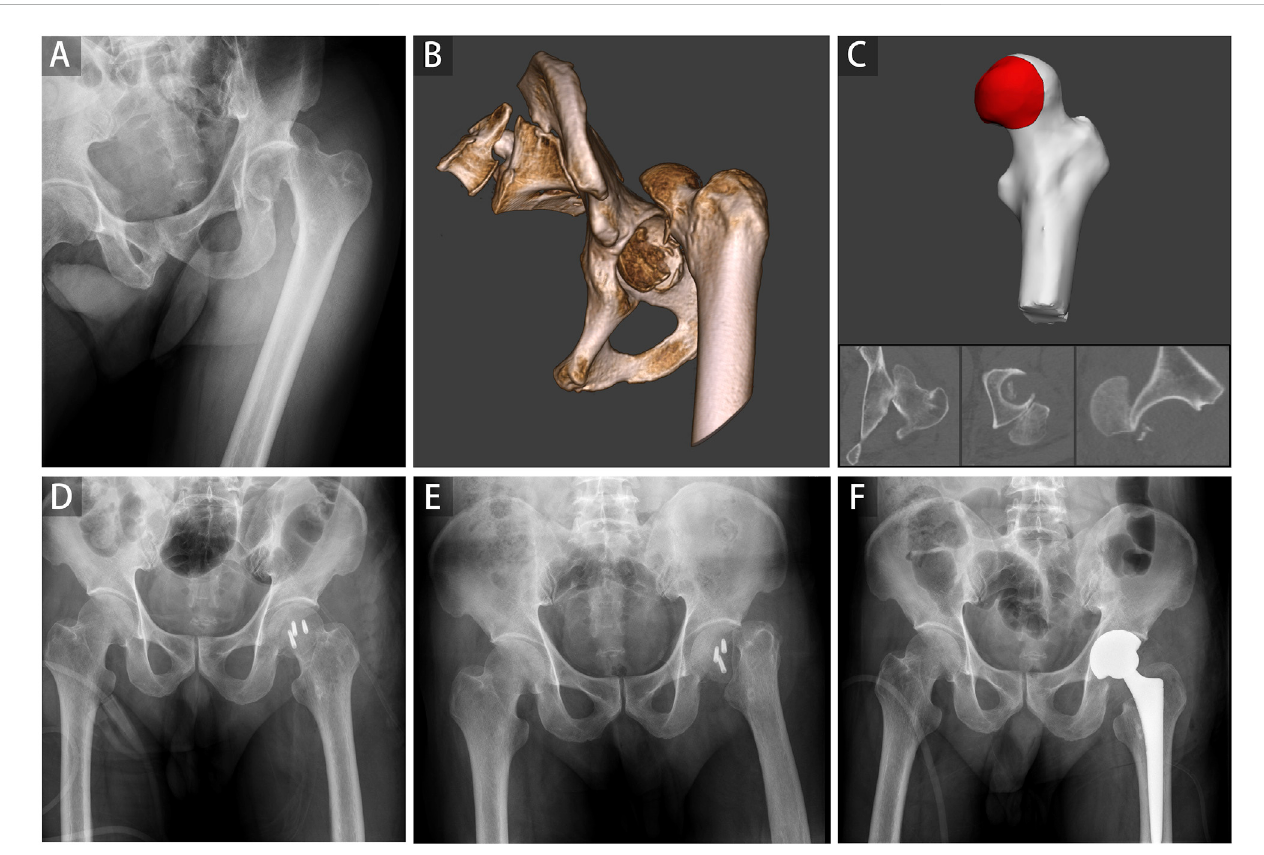
FIGURE 6 Arepresentativecaseoftherefractureofthefemoralneckafterinternal fi xationofthefemoralheadfracturewasshown.A62-year-oldmaninvolvedina severe traf fi c accident was diagnosed with femoral head fracture based on X-ray (A) and CT (B) . The average percentage of maximum defect length across threeplanesof96.64% inthe2Dinjury modeland thepercentage offracture area of40.72% inthe3Dinjury model weredetermined (C) .Openreduction and internal fi xationwereconducted,andthepostoperativeradiographshowedgoodreductionstatus (D) .Arefractureofthefemoralneckoccurredwithout trauma and fall 3 weeks postoperatively (E) . Finally, hip replacement surgery was performed (F)